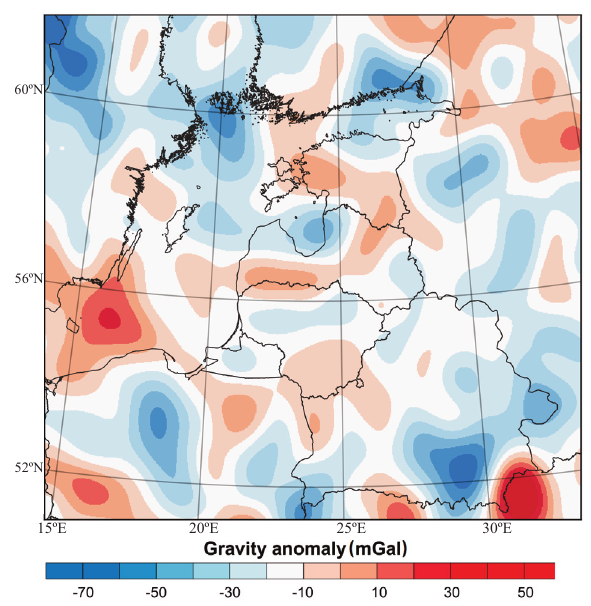
Fig. 3. The low­pass filtered gravity data of Fig. 2D, used in the calculation of the best performing model. The filter cut­off wavelength is 134 km.